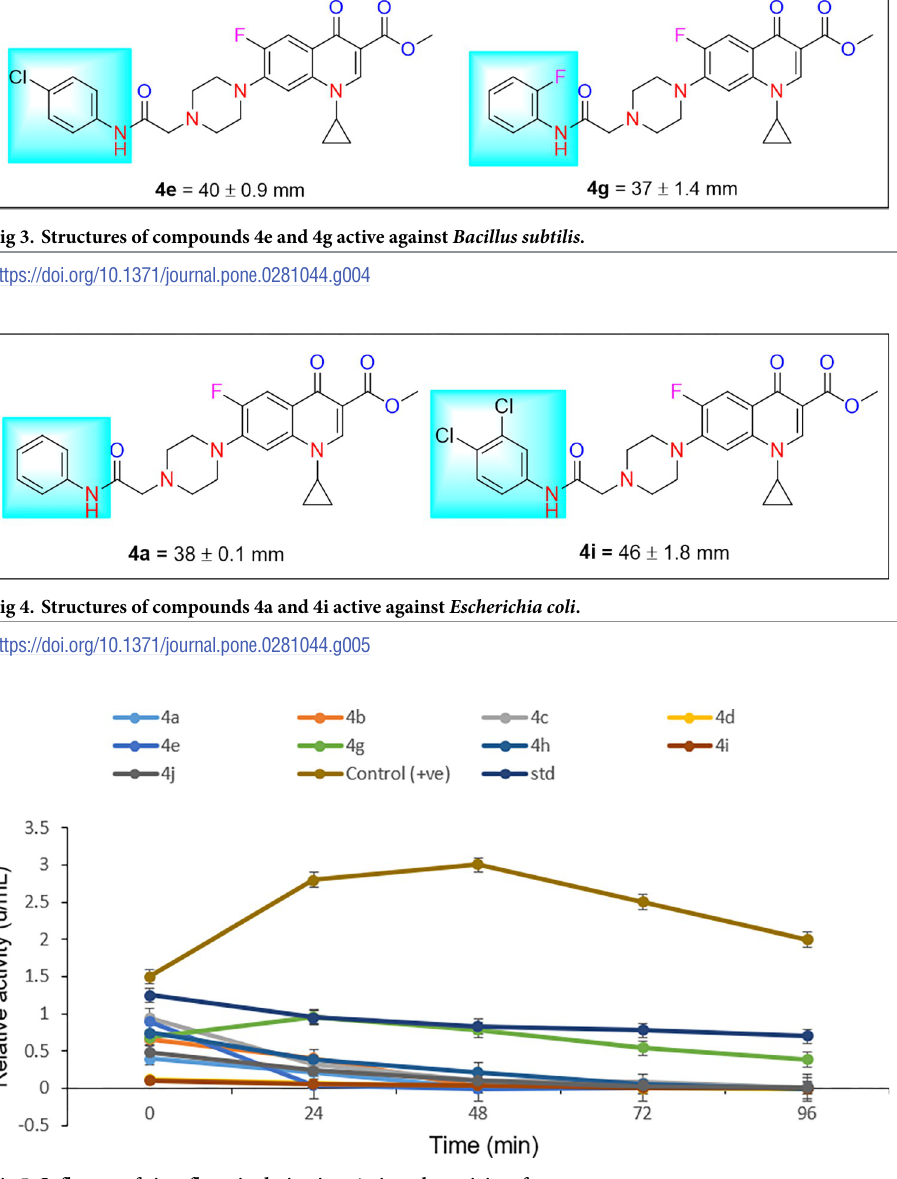
Fig 5. Influence of ciprofloxacin derivatives 4a-j on the activity of